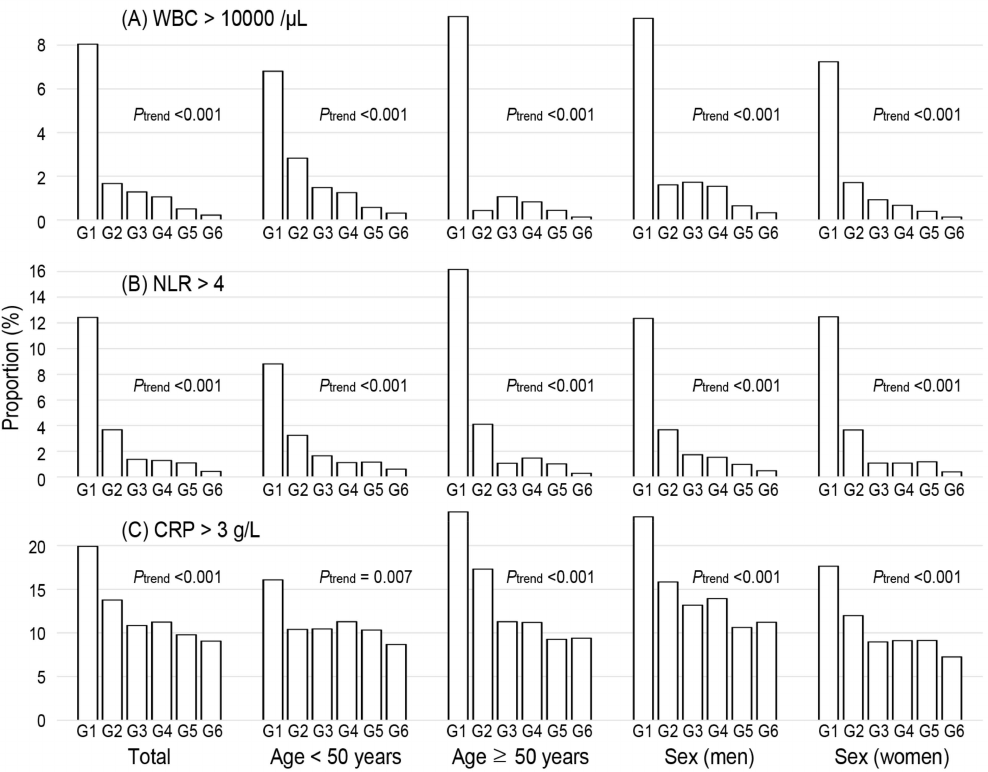
Figure 2. The proportion of high level of inflammatory markers according to the classification of baseline natural killer cell activity. G1–6 represents natural killer cell activity classification (G1, <100; G2, 100–250; G3, 250–500; G4, 500–1000; G5, 1000–2000; G6, ≥ 2000). The high level of inflammatory markers are defined as ( A ) white blood cell more than 10,000/ µ L, ( B ) neutrophil-to-lymphocyte ratio more than 4, and ( C ) C-reactive protein more than 3 g/L. p for trend was estimated using Cochran–Armitage tests. WBC, white blood cell; NLR, neutrophil-to-lymphocyte ratio, CRP, C-reactive protein.